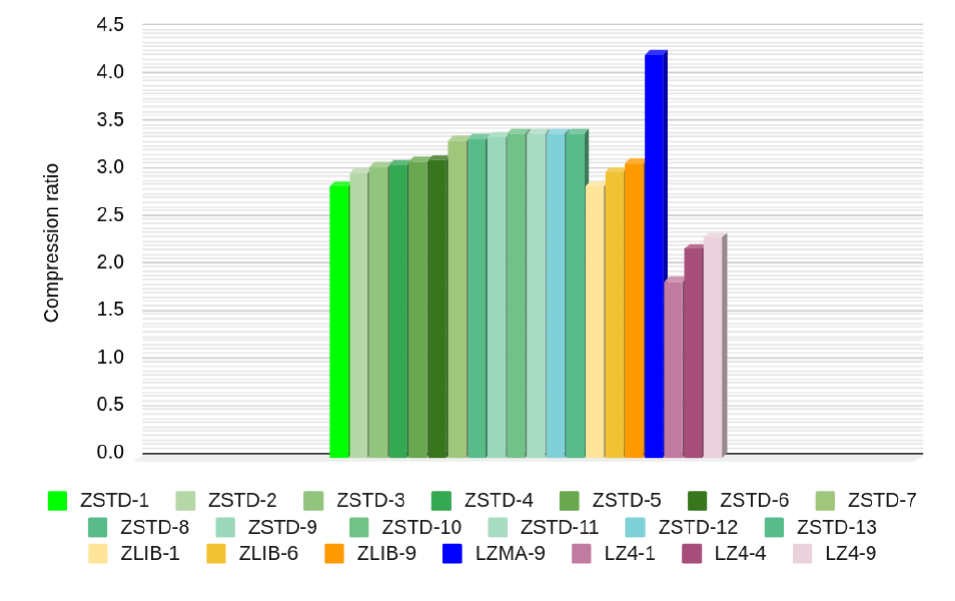
Figure 4. Comparison ratio comparison for custom analysis file with variable-sized data (containing C-style